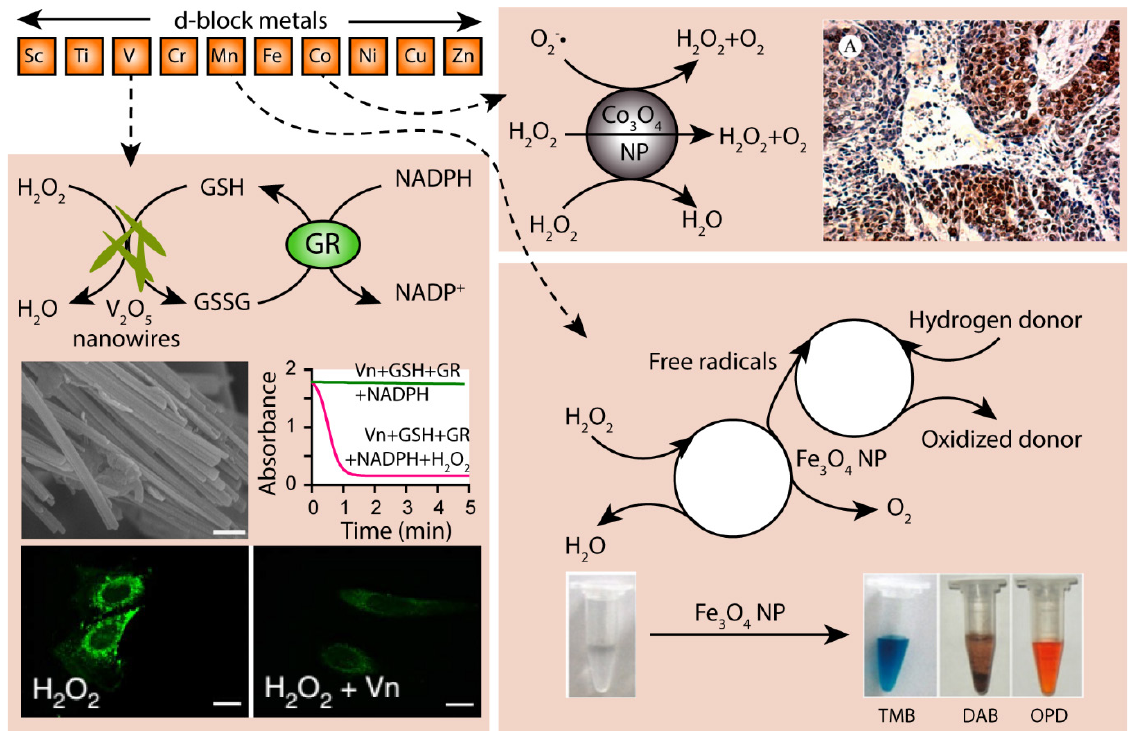
O ) NPs can function as SOD, CAT and 3 4 O ) nanowires. SEM image of the nanowires, the GPX like 2 5